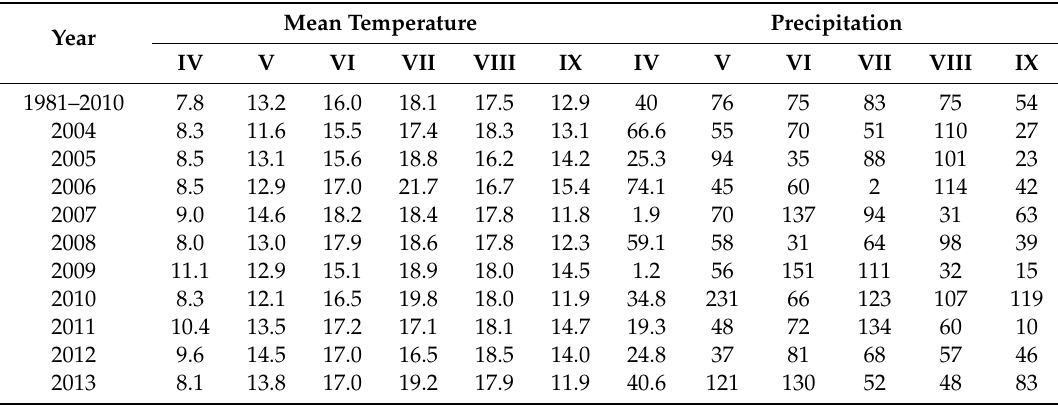
Table 1. Temperature and precipitation relative to 1981–2010.